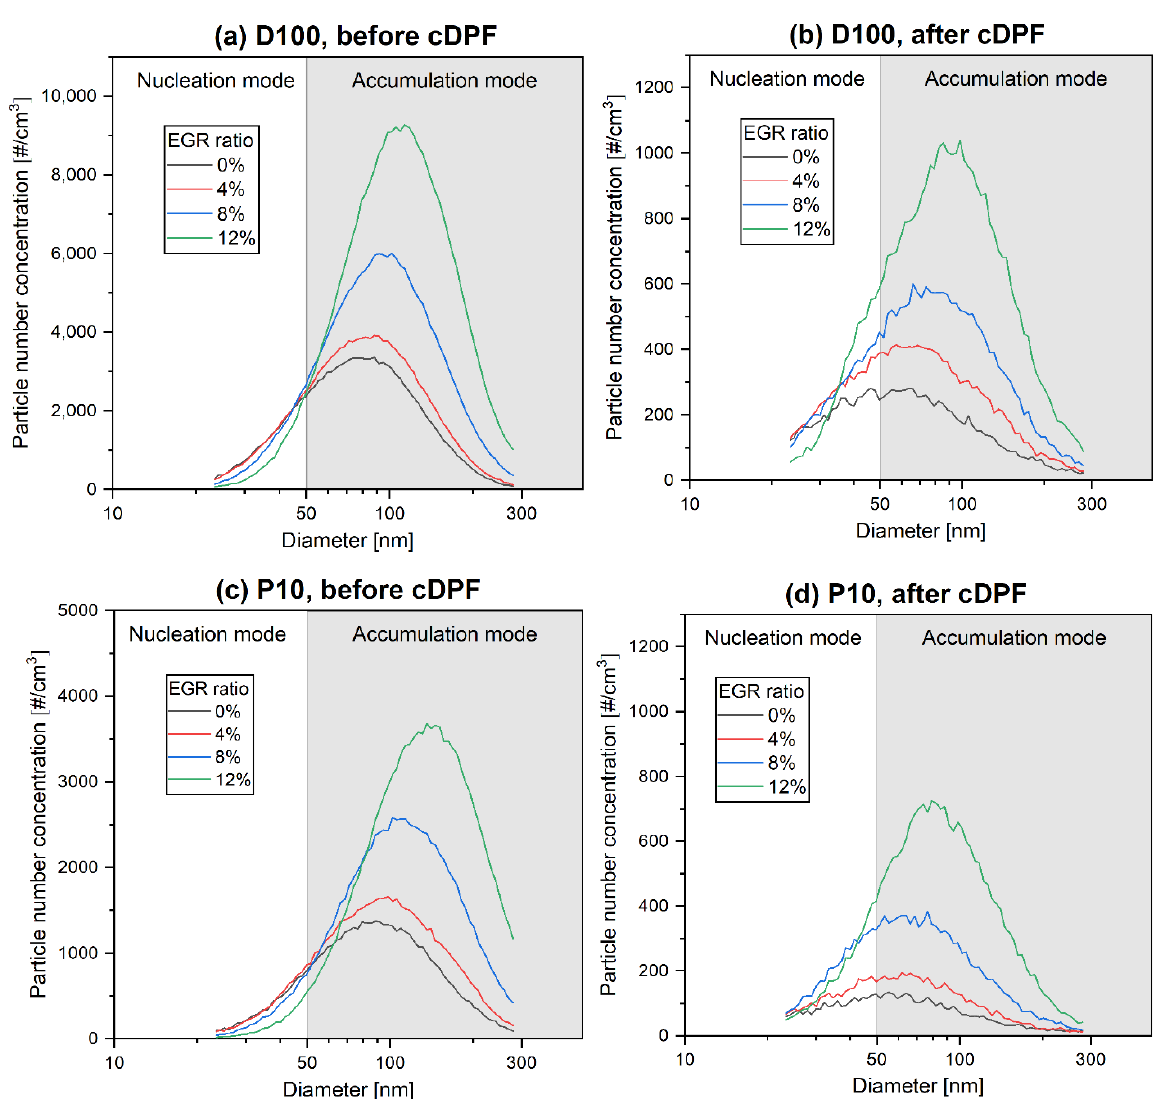
Figure 3. Particulate number and size distributions under various EGR rates: ( a ) D100 fuel, before cDPF; ( b ) D100 fuel, after cDPF; ( c ) P10 fuel, before cDPF; and ( d ) P10 fuel, after cDPF.